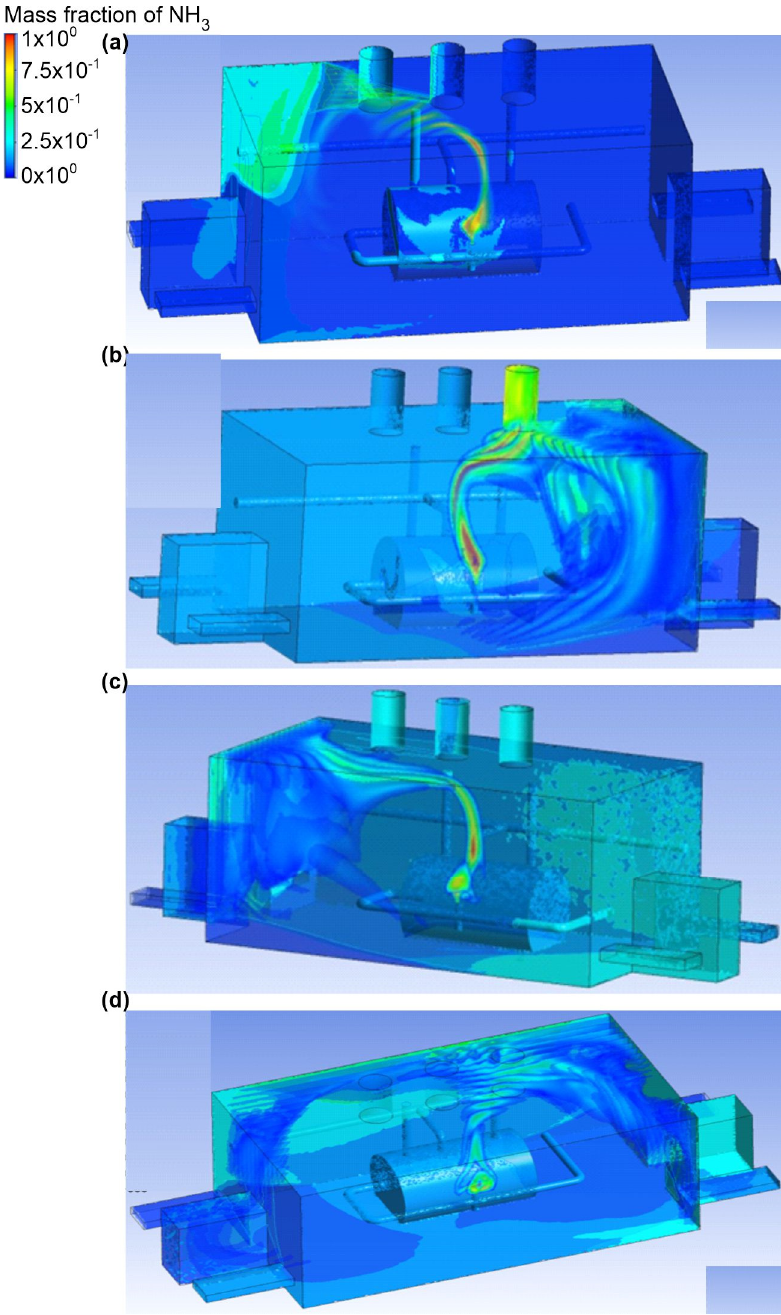
Figure 4. Ammonia distribution in the engine room for: ( a ) scenario A, ( b ) scenario B, ( c ) scenario C, and ( d ) scenario D.